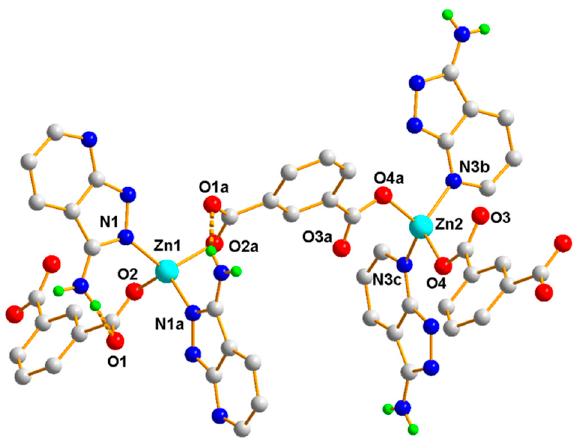
Figure 2. The coordination environment of the Zn(II) ions in Polymer 1. The brown dotted lines depict the hydrogen-bonding interactions, while other hydrogen atoms have been omitted for